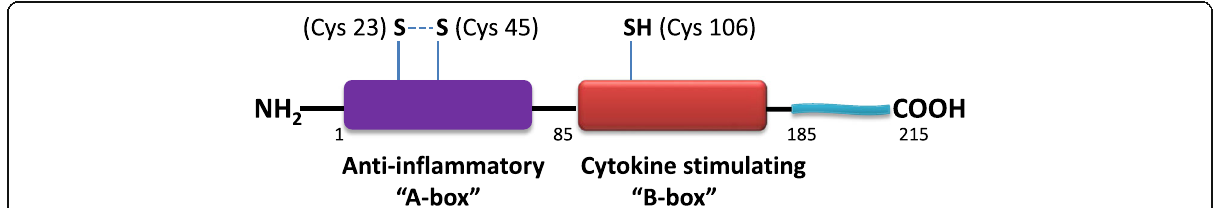
Fig. 1 HMGB1 is composed of two box domains that individually have unique biological